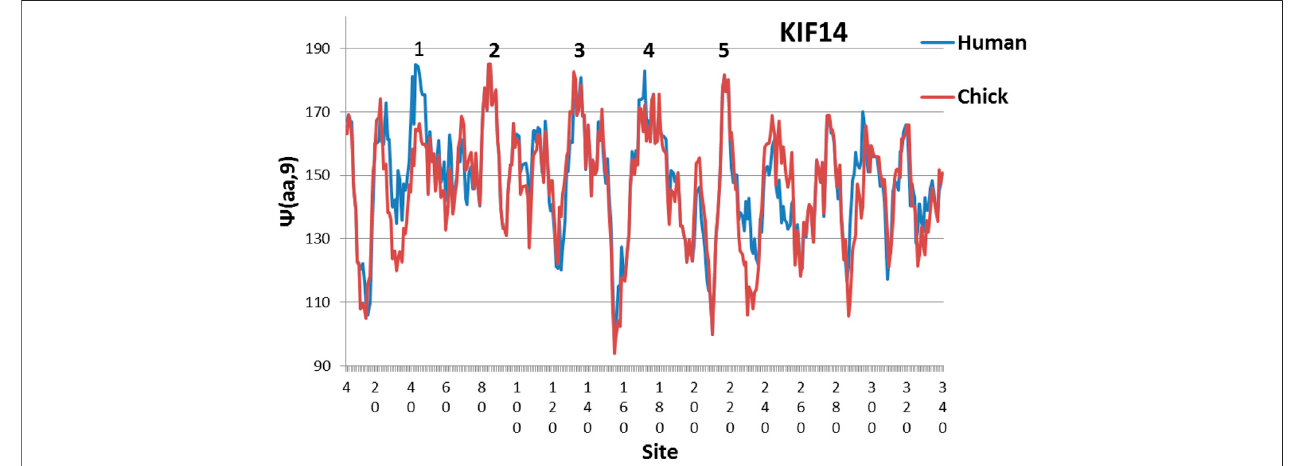
FIGURE 1 | Evolution leveled hydrophobic peaks 2, 3 and 5 in chicken KIf14 motor pro fi les with W = 9, and further evolution added level peaks 1 and 4 in human. The reader may also observe partial leveling from chickens to humans of the fi ve lowest hydrophilic minima near 10, 150, 210, 230 and 290. The MZ scale is used here (Moret and Zebende, 2007; Phillips, 2020). In other proteins the number of level peaks is usually only three (Phillips, 2009)